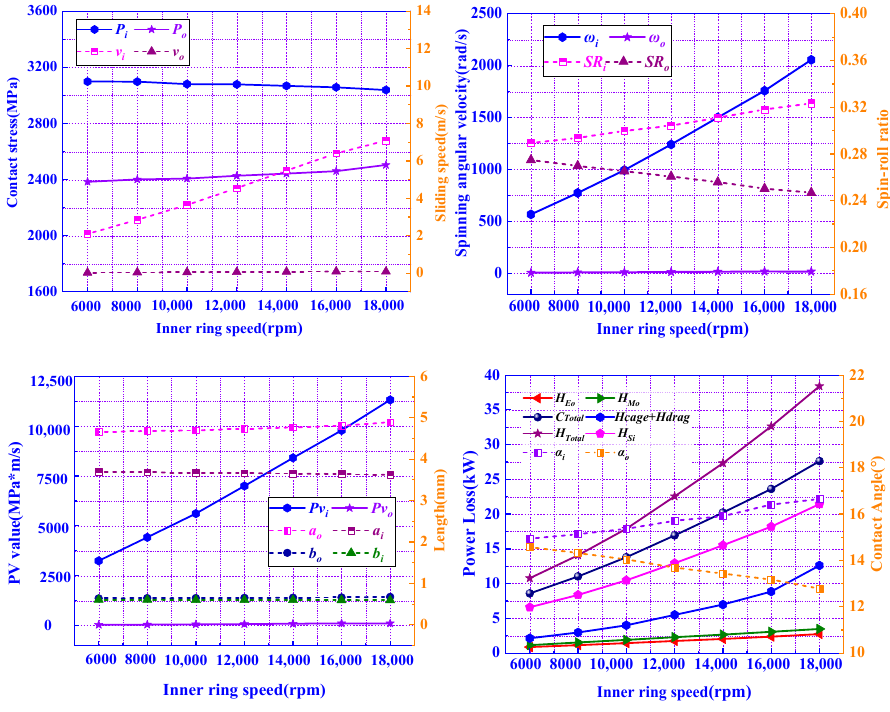
Figure 20. Influence of bearing speed n i on power loss.